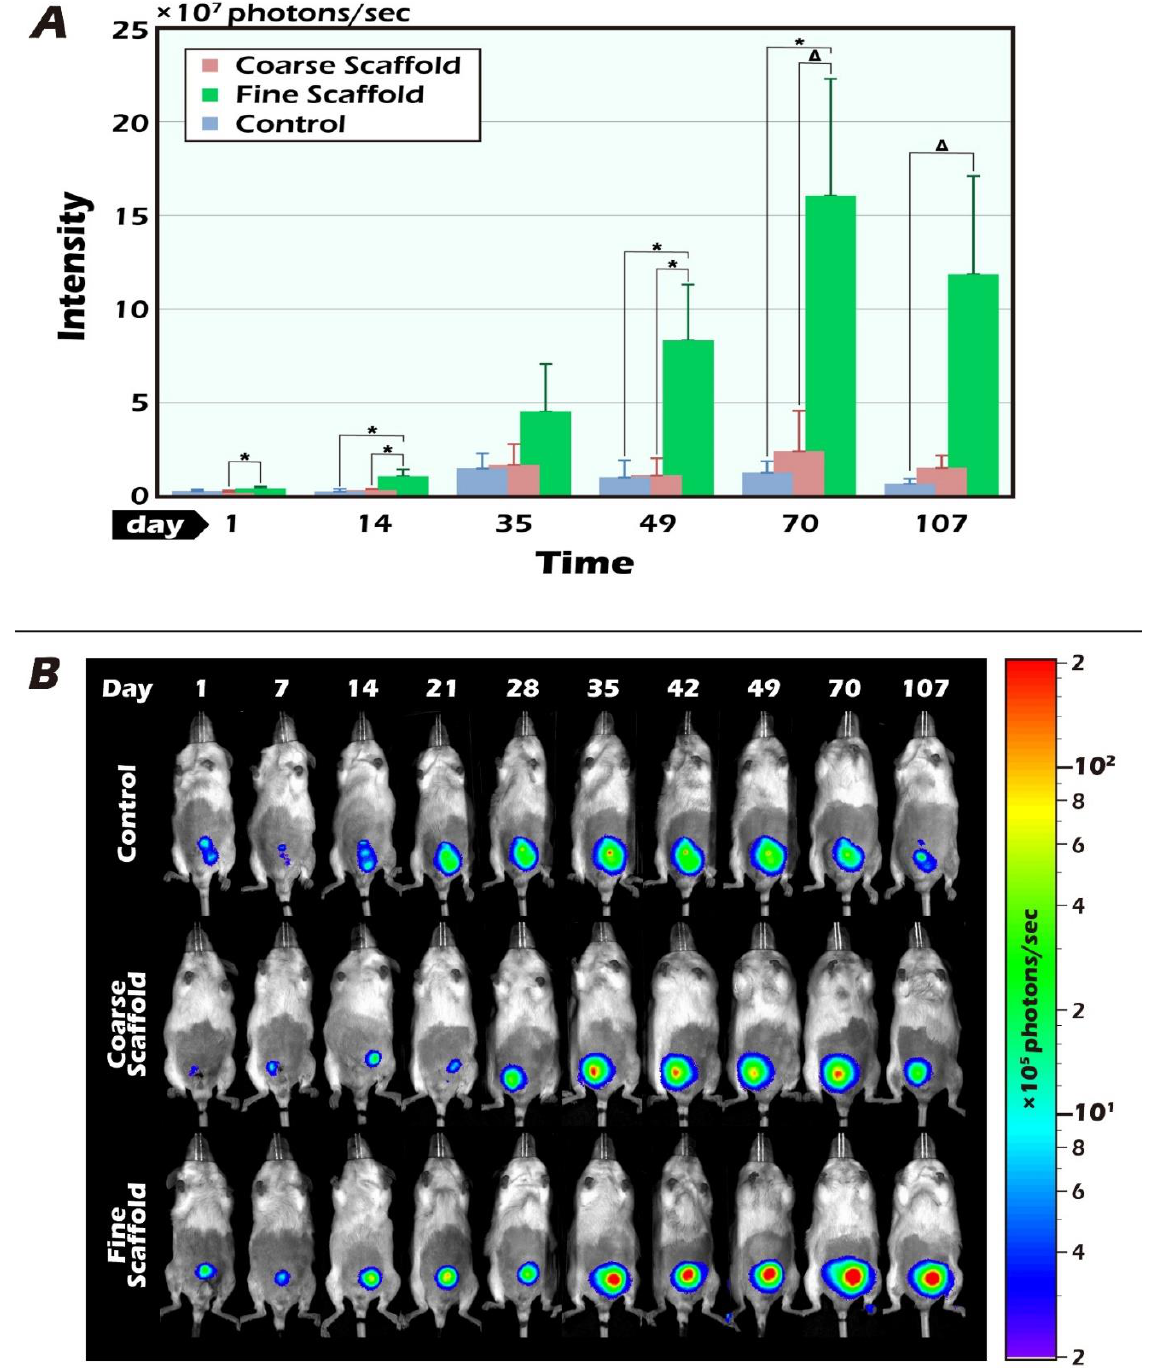
Figure 2. ( A ) Longitudinal bioluminescent imaging of luciferase activation. Four-week-old recip- ients, where the transplanted donor testicular tissue was age-matched to the scrotum of bilateral orchiectomy with coarse, fine, or without an electrospun PLLA mat. The grafted testis tissue with an electrospun PLLA mat could increase the degree of cell regeneration compared with and without the scaffold, in particular on days 14, 49, 70, and 107 after transplantation when compared between the fine scaffold group and control group (* p < 0.05, ∆ p = 0.05). Based on the BLI quantity, the signal intensity of the immature testicular graft survival increased to the crucial peak between the 49th and 70th days and then decreased at the end of the 107th tracking day. The quantity of BLI showed significantly effective but peak BLI intensity with the fine electrospun PLLA mat. ( B ) Representative pattern of in vivo tracking of the BLI image of a typical in situ ITT engraftment in an